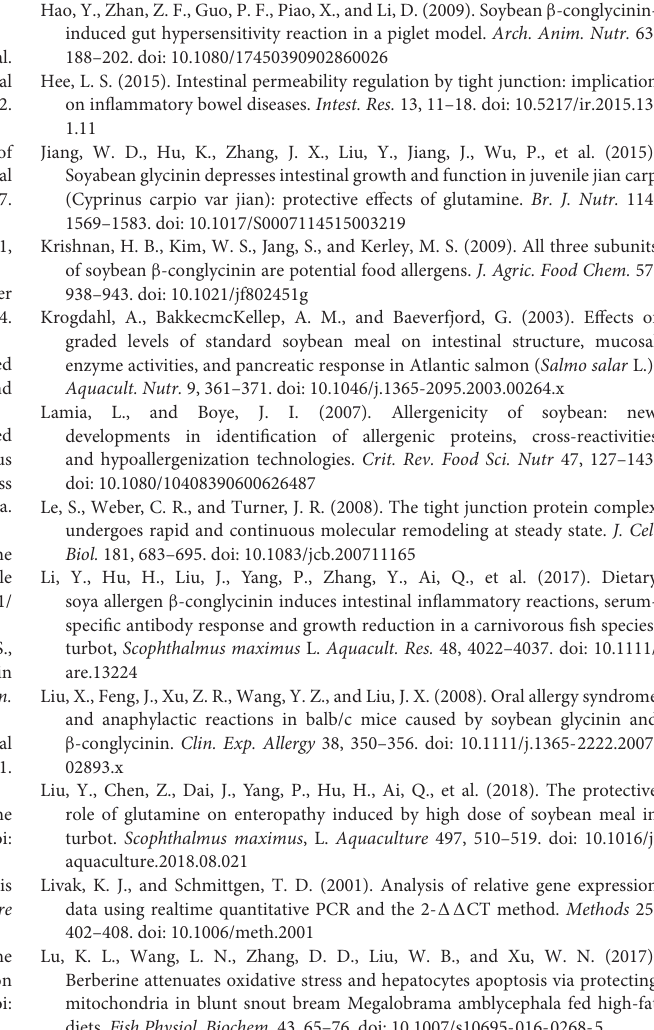
FIGURE S1 | Histological changes of the distal intestine section from turbot in 7S&FM group at the zero day (A) , the third day (B) , the first week (C) , the second week (D) , the third week (E) , the sixth week (F) and the tenth week (G) . MF: mucosal fold; MM: muscularis mucosa; SML: submucous layer; Scale bar, 500 µ m. Staining: H & E. FIGURE S2 | The original blots of SDS-PAGE. The lines from left to right are 7S, 11S, protein marker, 7S, 11S, protein marker, 11S and 11S. The part in the frame was used in the